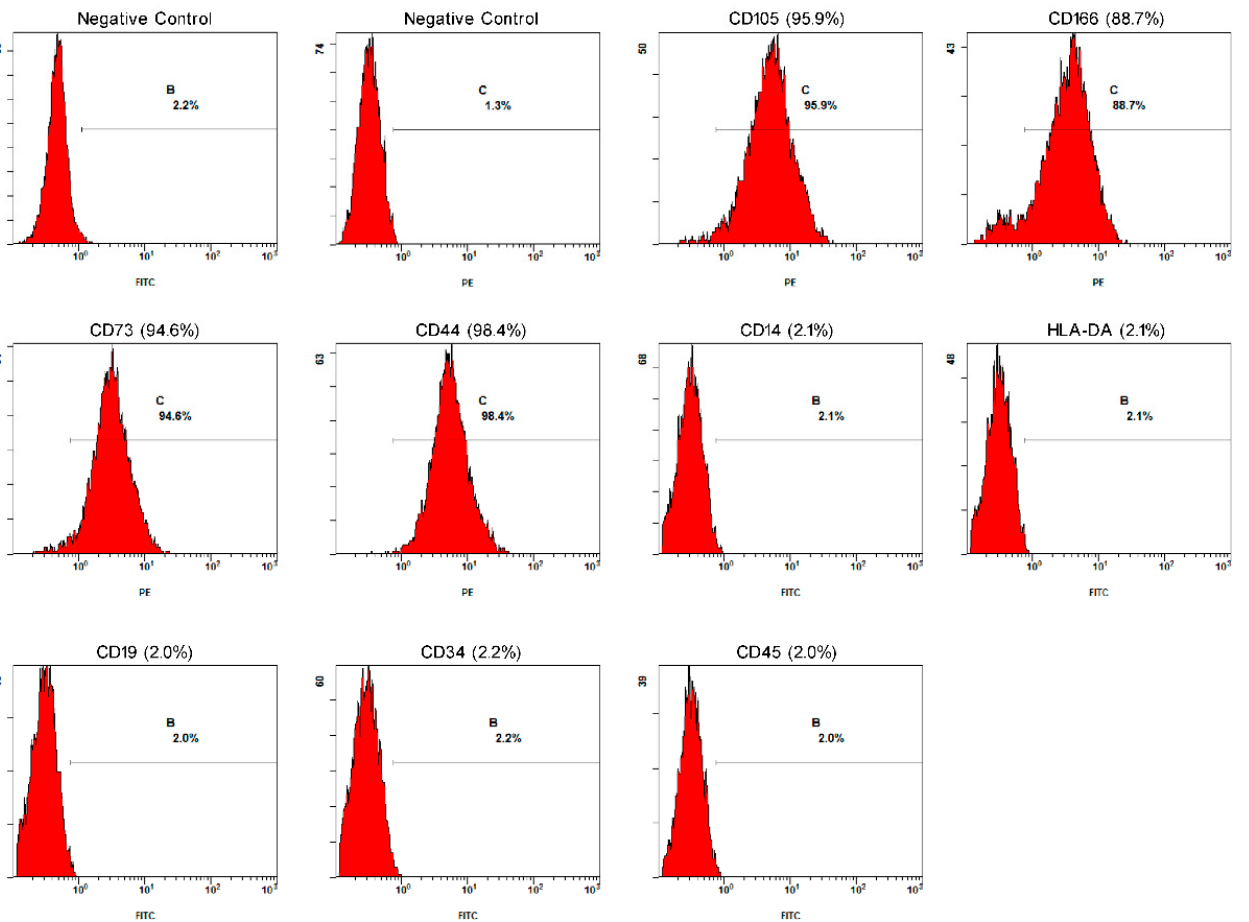
Figure 3. MSC expressed marker genes. Negative control without fluorescence staining of FITC and PE. The expression of CD105, CD166, CD73, CD44, CD14, HLA-DR, CD19, CD34, and CD45 in MSCs at 3 passages was detected by FACS. MSCs positively expressed CD105, CD166, CD73, CD44, but negatively expressed CD14, HLA-DA, CD19, CD34, CD45. B and C in the FACS panels represent FITC and PE-positive cells, respectively.